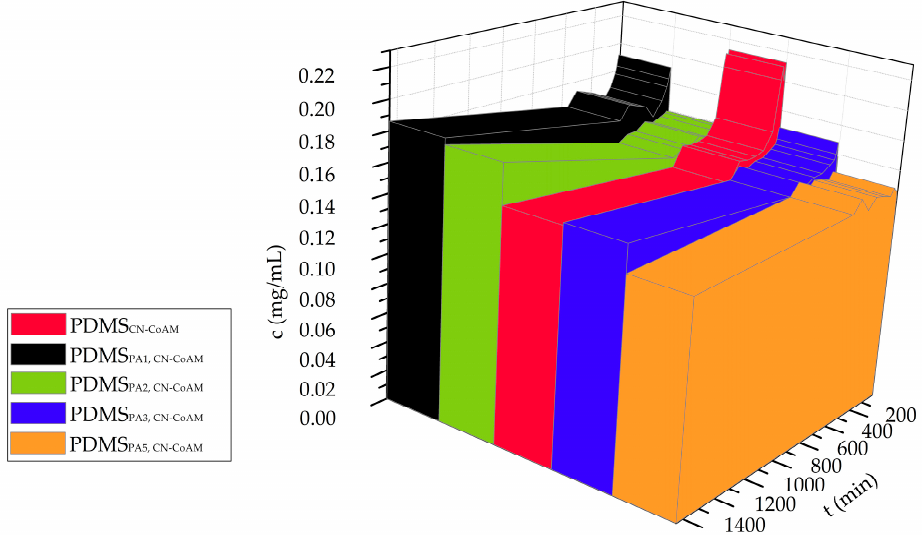
Figure 4. Time-dependent change in the active substance concentration.